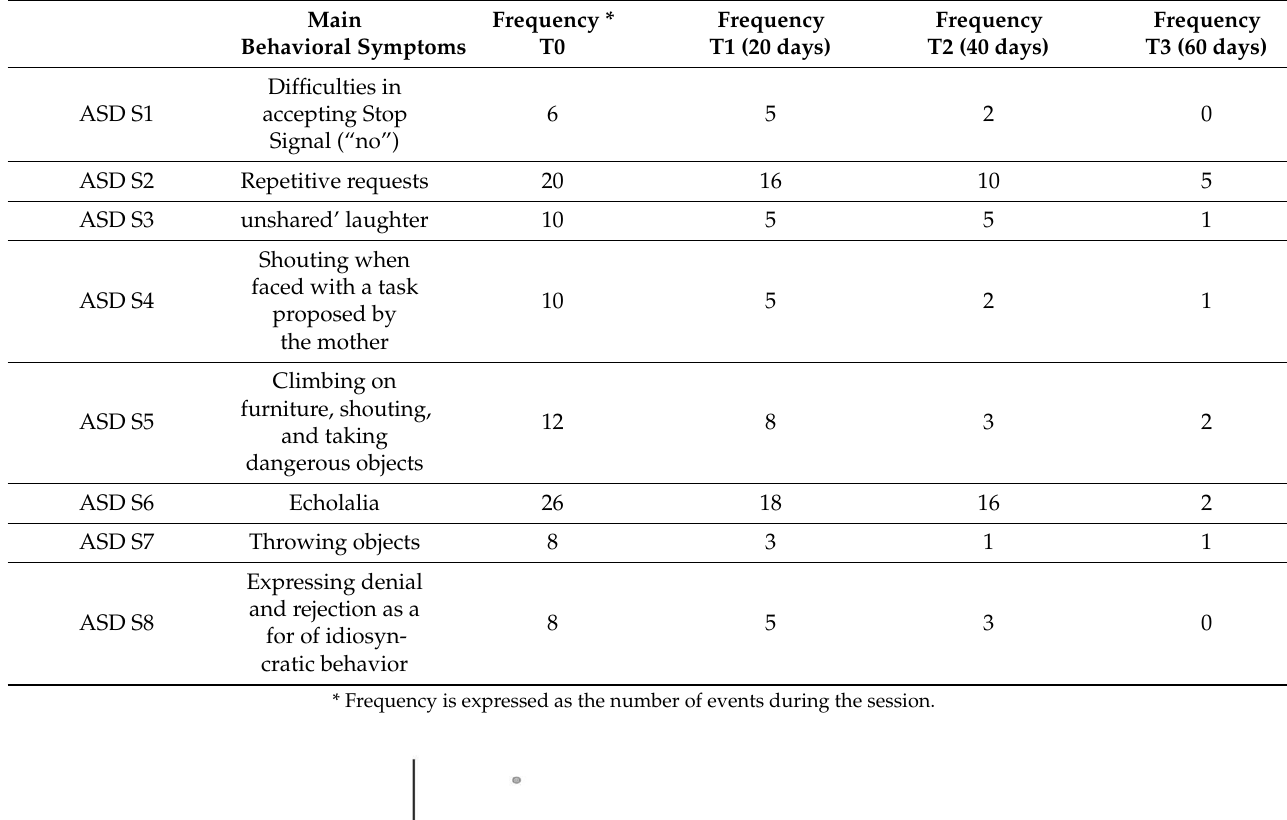
Table 7. Psychological effects on parents before and after BST treatment.